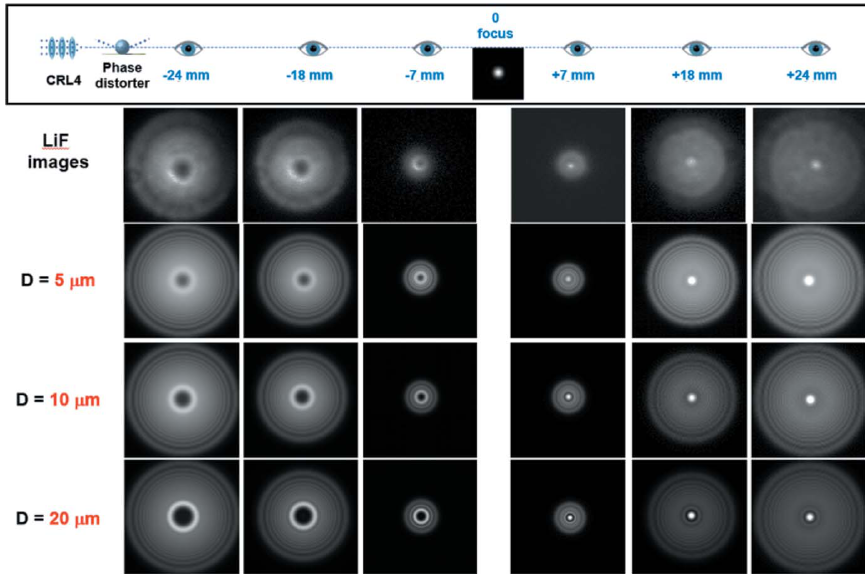
Figure 8 Same as in Fig. 7 for modeling with a change in the thickness of the phase distorter in the range D = 5– 20 m m (parameter FWHM = 30 m m fixed).